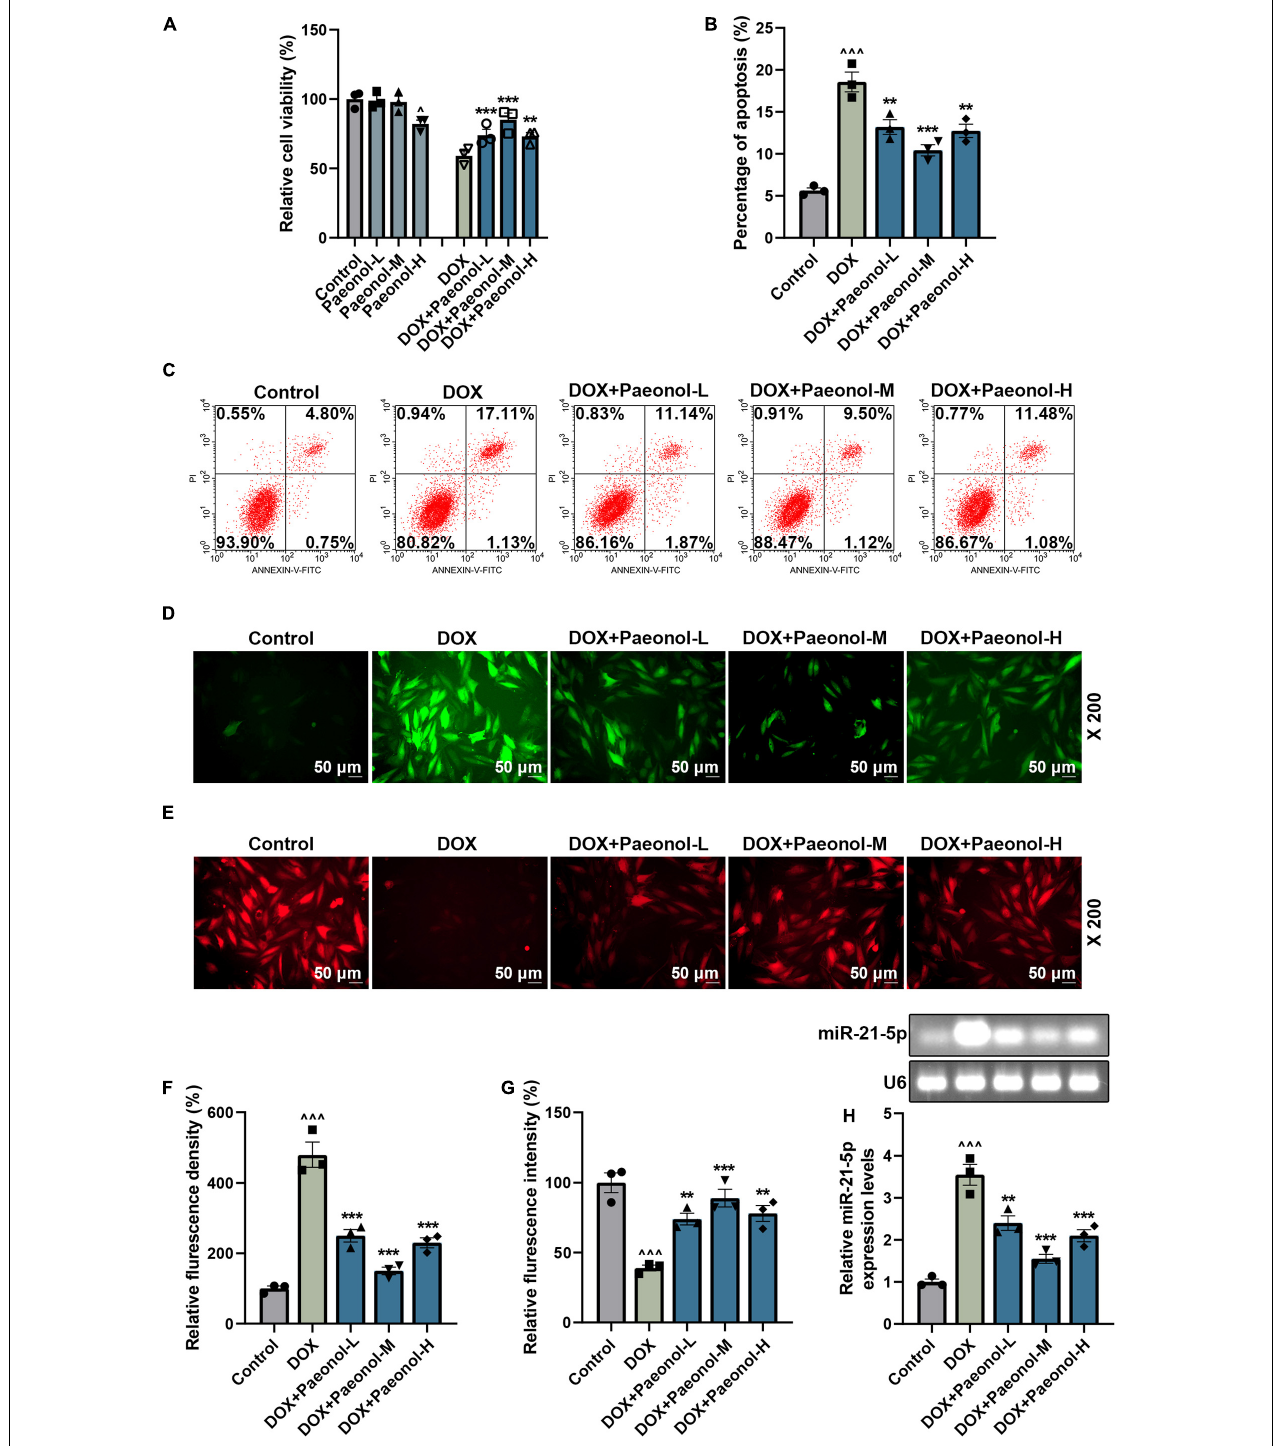
FIGURE 3 | Paeonol increased the MMP and viability, while decreasing the apoptosis and ROS, and suppressing miR-21-5p expression in the DOX-induced cardiomyocytes. (A) The viability of H9c2 cells treated with DOX or paeonol was detected by CCK-8 assay. (B,C) The apoptosis of H9c2 cells treated with DOX or paeonol was determined via flow cytometry. (D,F) The level of ROS in the H9c2 cells treated with DOX or paeonol was visualized by H2DCFDA staining. (E,G) The MMP in the H9c2 cells received the treatment with DOX or paeonol and was detected using TMRM staining. (H) The expression of miR-21-5p in H9c2 cells treated with DOX or paeonol was quantified with the help of RT-qPCR. U6 served as an internal control. ∧ P < 0.05, ∧∧∧ P < 0.001 vs. Control; ** P < 0.01, *** P < 0.001 vs. DOX. DOX, doxorubicin; MMP, mitochondrial membrane potential; ROS, reactive oxygen species.